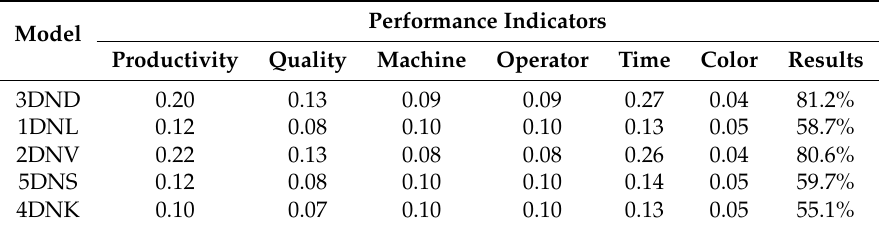
Table 11. Concentration of results of the performance indicators for each die-nozzle models.